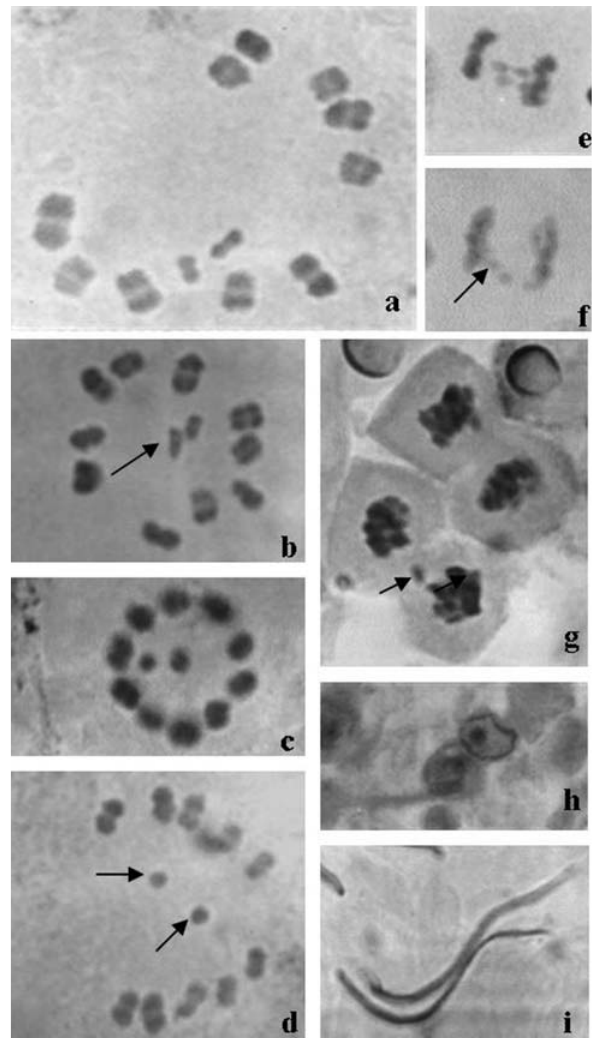
Figure 3 - Testicular tubules of Triatoma klugi after lacto-acetic orcein staining: (a-b) Metaphase I with ten bivalent autosomes and two sex chro- mosomes indicated by the arrow; (c-d) Metaphase II with equational divi- sion of the sex chromosomes shown by arrows. Note that in (c) the chro- mosomes are arranged in a ring; (e-f) Anaphase with late chromosomes migration, the arrow indicates parallel chromosome migration; (g) Telo- phase II with four gametic cells, the arrow indicates late migrating chro- mosomes; (h) Spermatids with heteropycnotic corpuscles in early spermiogenesis, (i) Sperm cells at the advanced differentiation